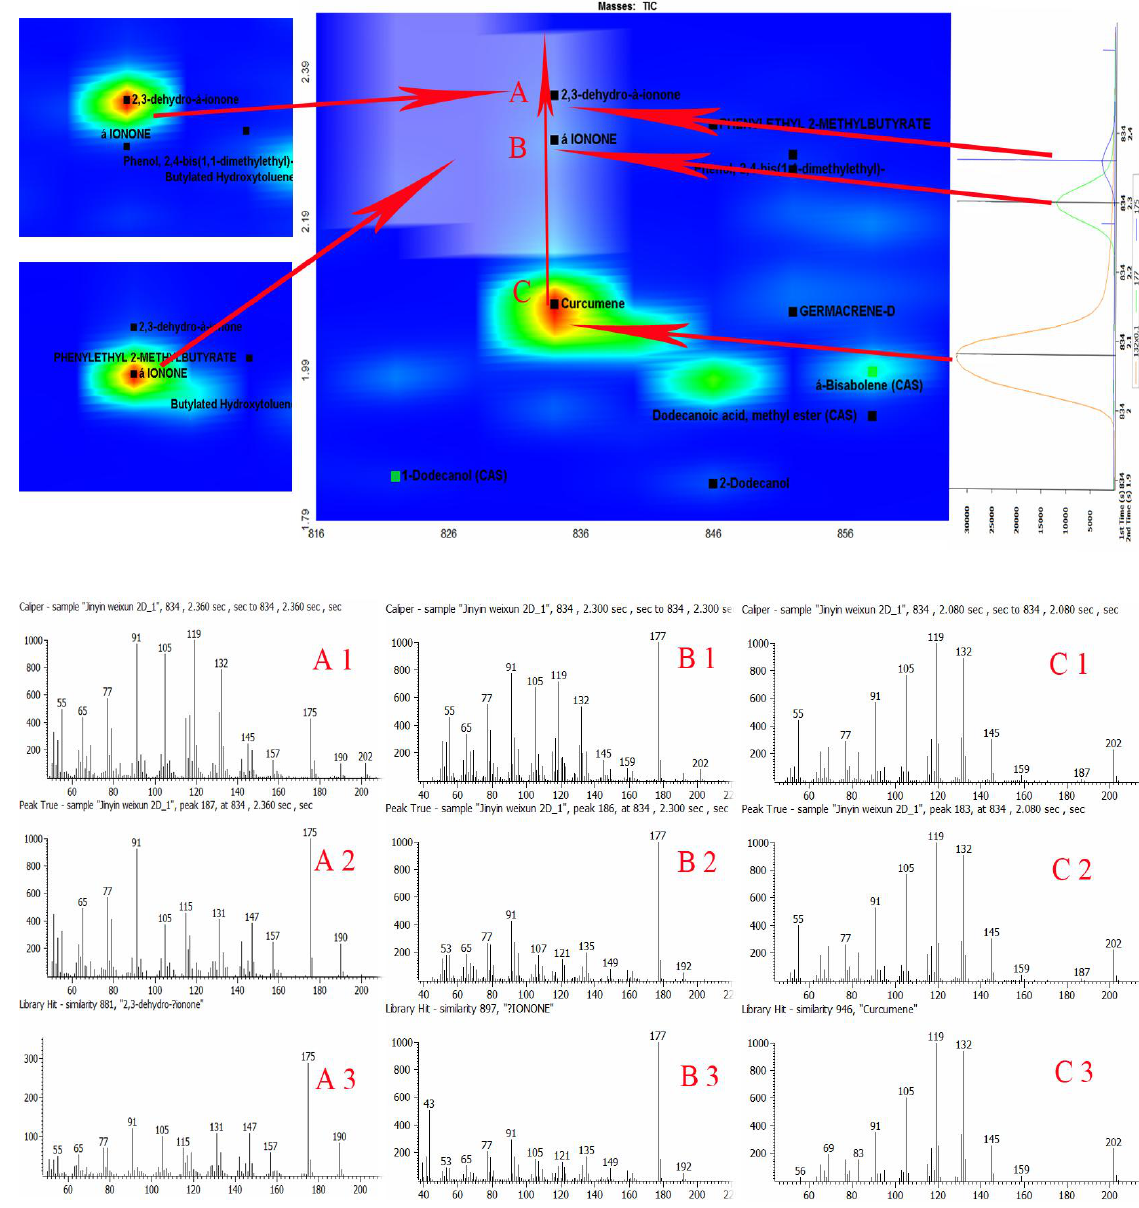
Figure 3. The identified chemical groups of Flos Lonicerae Japonicae volatile oil in the GC×GC chromatograms and the spectra of 2,3-dehydro-α-ionone ( A ), α-ionone ( B ) and curcumene ( C ) in sample and in NIST library, respectively (1: Caliper Spectra; 2: Deconvoluted Spectra; 3: NIST Library